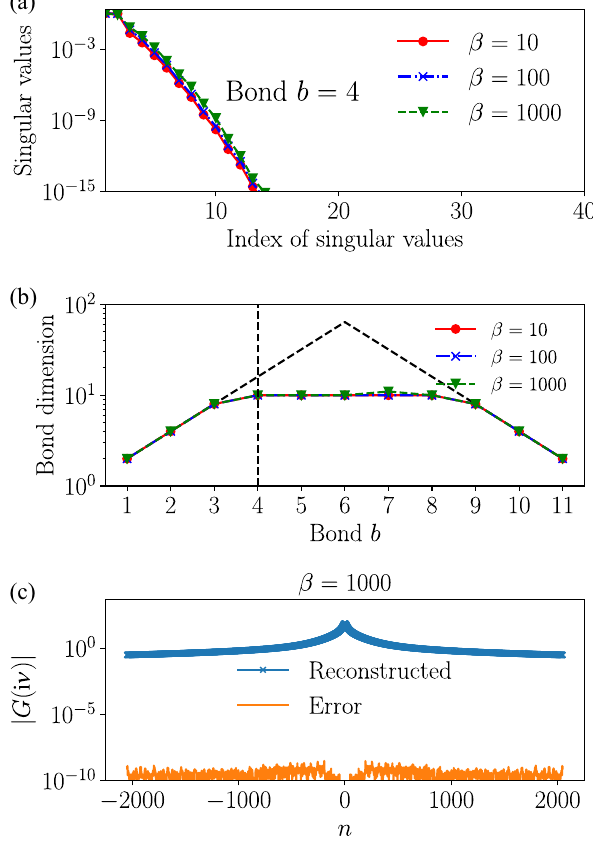
FIG. 7. Compression of G ð i ν Þ for the same model as in Fig. 6 with R ¼ 12 . (a) Singular values at b ¼ 4 , (b) bond dimensions, (c) comparison between the exact and reconstructed data. In (b), the dashed line indicates the maximum bond dimensions in maximally entangled